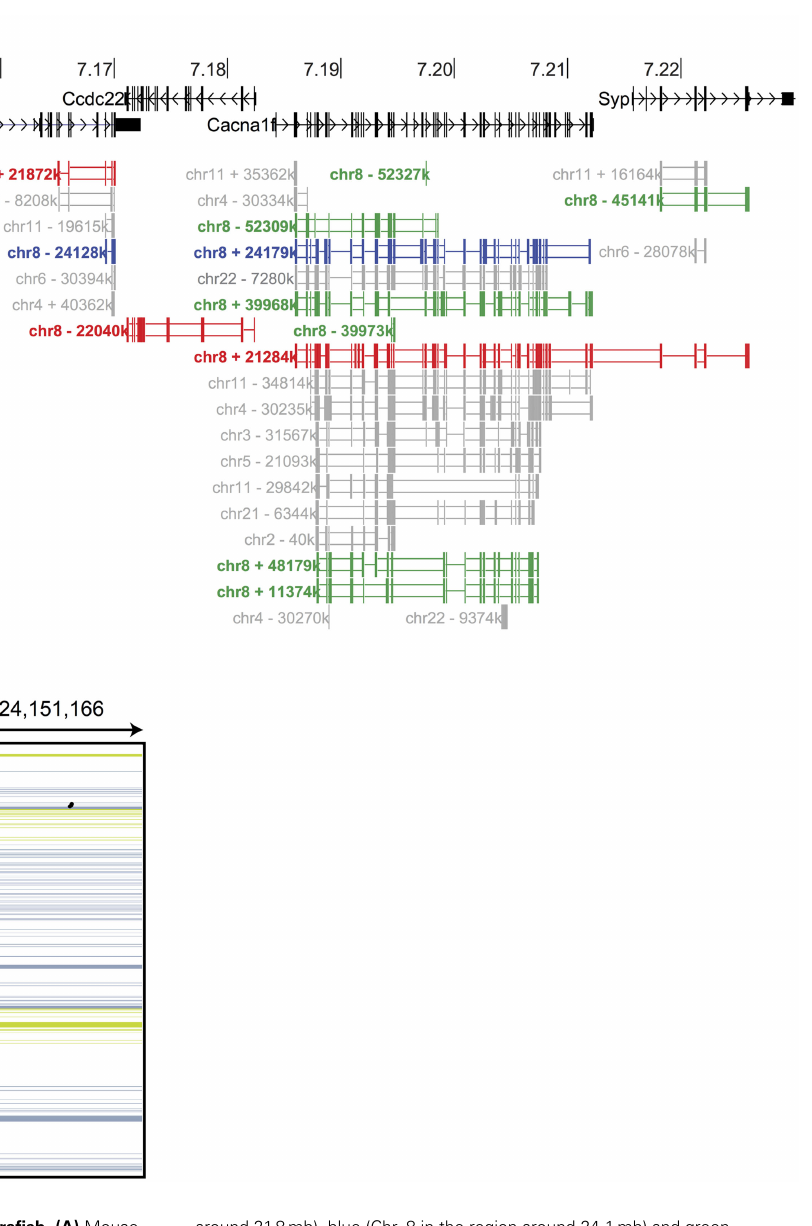
FIGURE 2 | Syntenic analysis of the Foxp3 loci in zebrafish. (A) Mouse Chr. X 7.135–7.235mb containing the foxp3 locus and flanking regions with exons shown as vertical black bars. A discontinuous whole genome nucleotide alignment of the zebrafish genome as determined using BLASTZ (Schwartz et al., 2003) in the UCSC genome browser (Kent et al., 2002) is shown below. Alignments from Chr. 8 are shown in red (Chr. 8 in the region